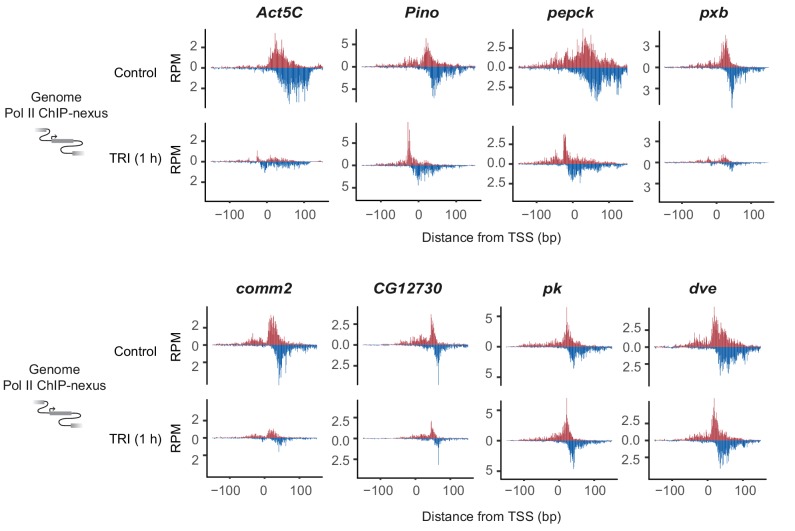
Paused Pol II stability measurements at eight D. pseudoobscura promoters.Pol II ChIP-nexus was performed on the D. pseudoobscura cell line ML83-63. The stability of paused Pol II was analyzed by comparing the Pol II profile under control and triptolide (TRI) treated conditions. The eight D. pseudoobscura promoters shown in this figure have high Pol II signal and various degrees of Pol II pausing. The sequences of these promoters were cloned into our reporter and used for later mutagenesis experiments.